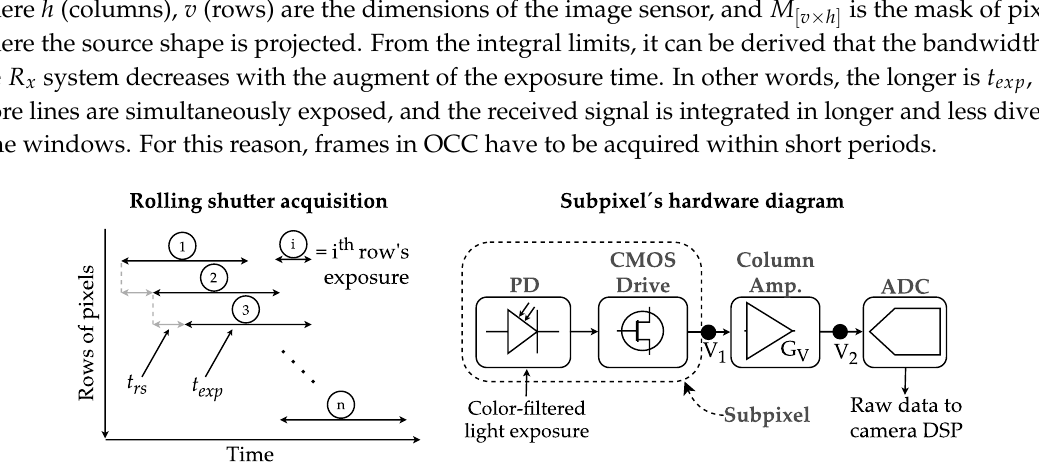
Figure 1. Typical configuration of Complementary Metal-Oxide-Semiconductor (CMOS) camera